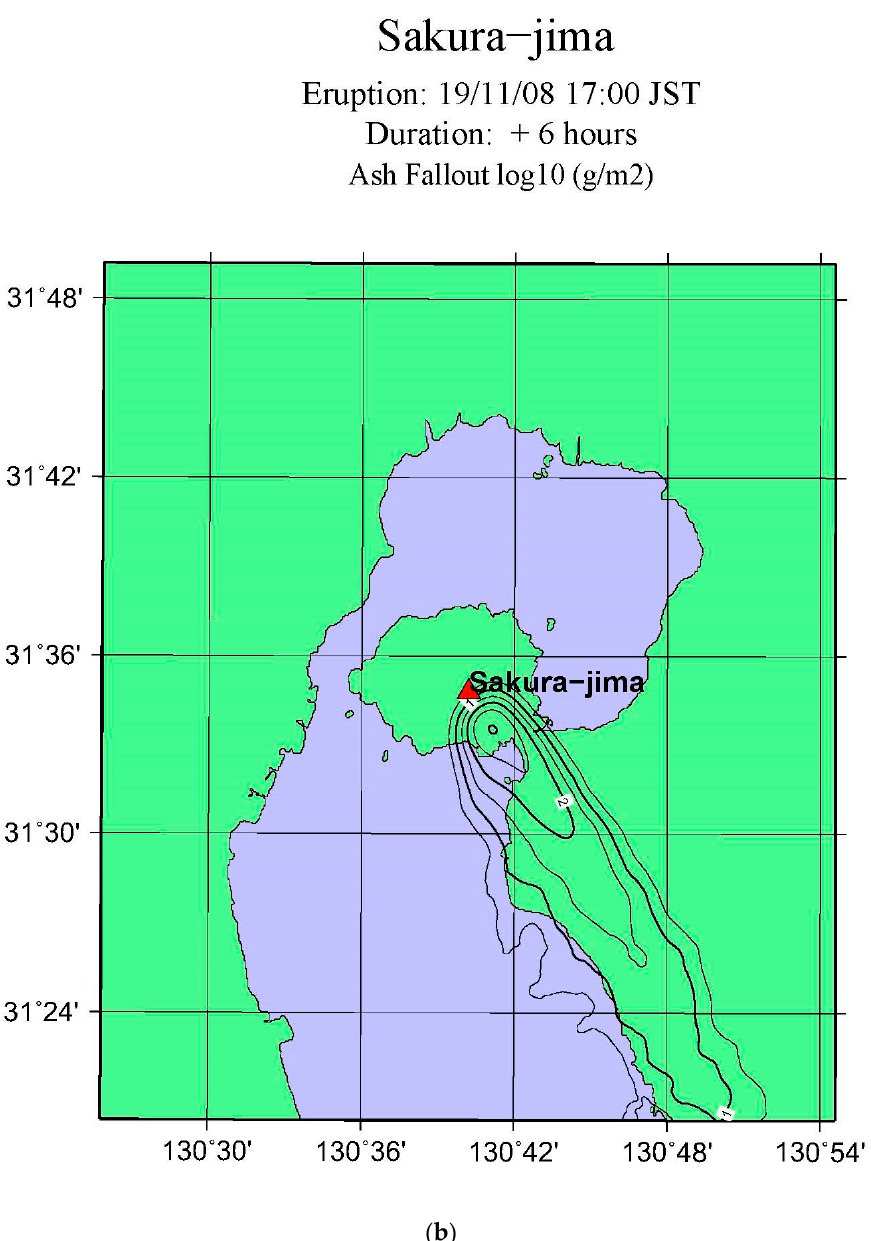
Figure 5. ( a ) Particle distribution of ash fallout over 6 h from the onset of the eruption on 8 November 2019. ( b ) The estimated concentration of ash fallout (g/m 2 ) in common log-scale, i.e., 1.0 denotes 10 g/m 2 , calculated by counting the number of fallout particles using 100 m grid meshes.